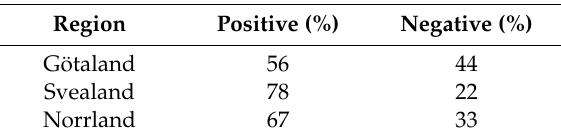
Table 10. FFOs’ willingness to actively develop stands suitable for whole-tree harvesting in early thinning, e.g., through less intense